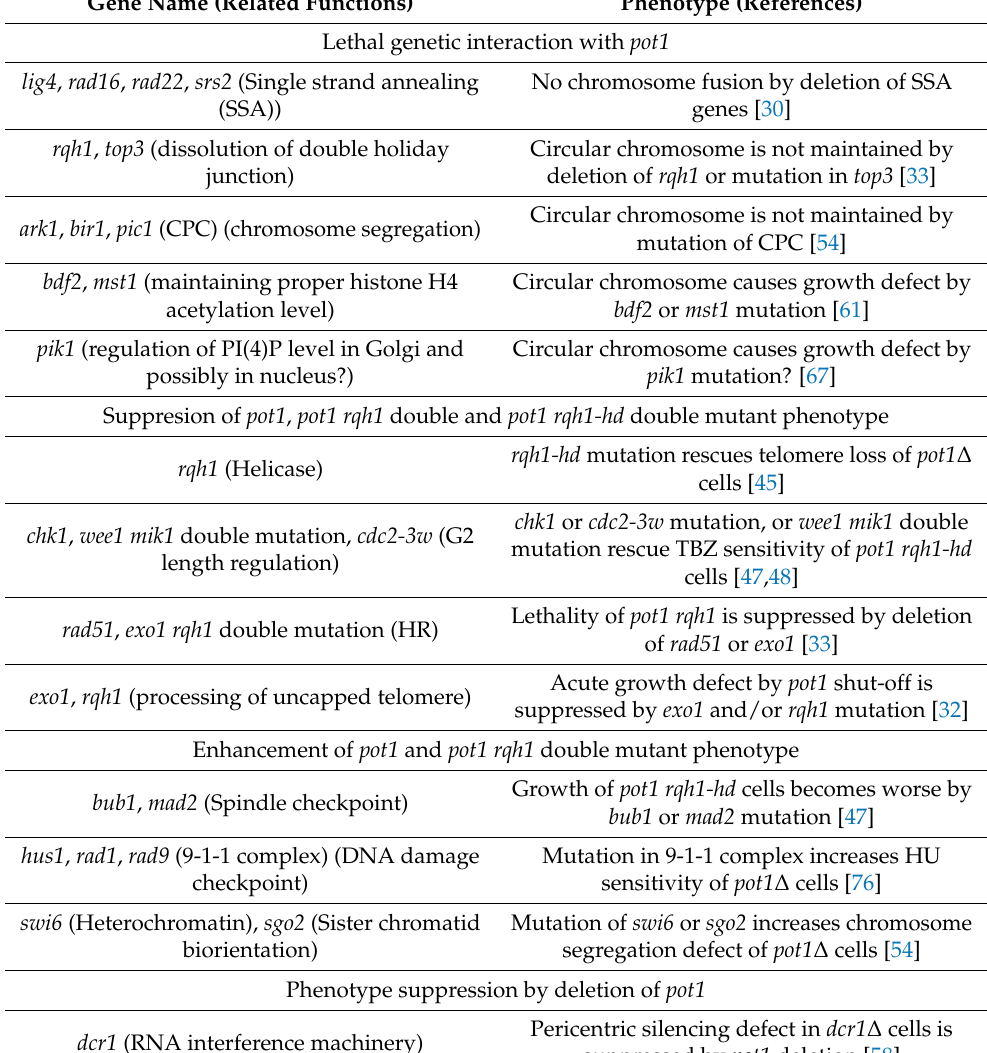
Table 1. Summary of pot1 (cid:48) s genetic